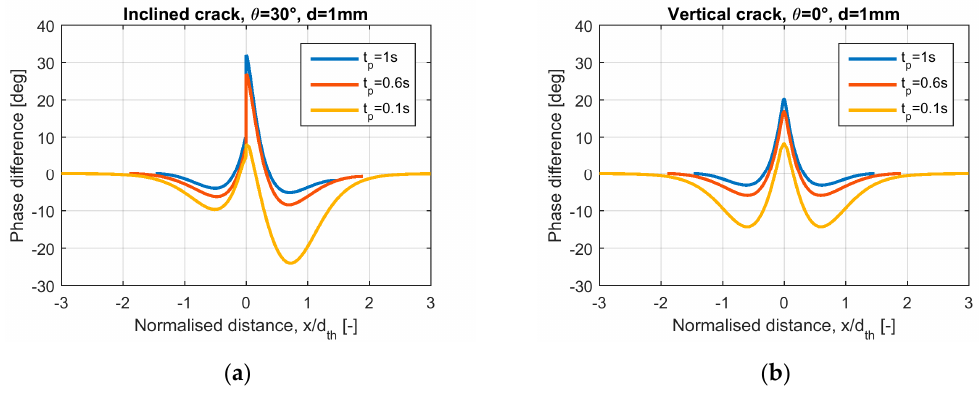
Figure 13. (a) Phase around the crack shown in Figure 12 with different heating pulses; (b) phase for a vertical crack with the same d = 1 mm depth.